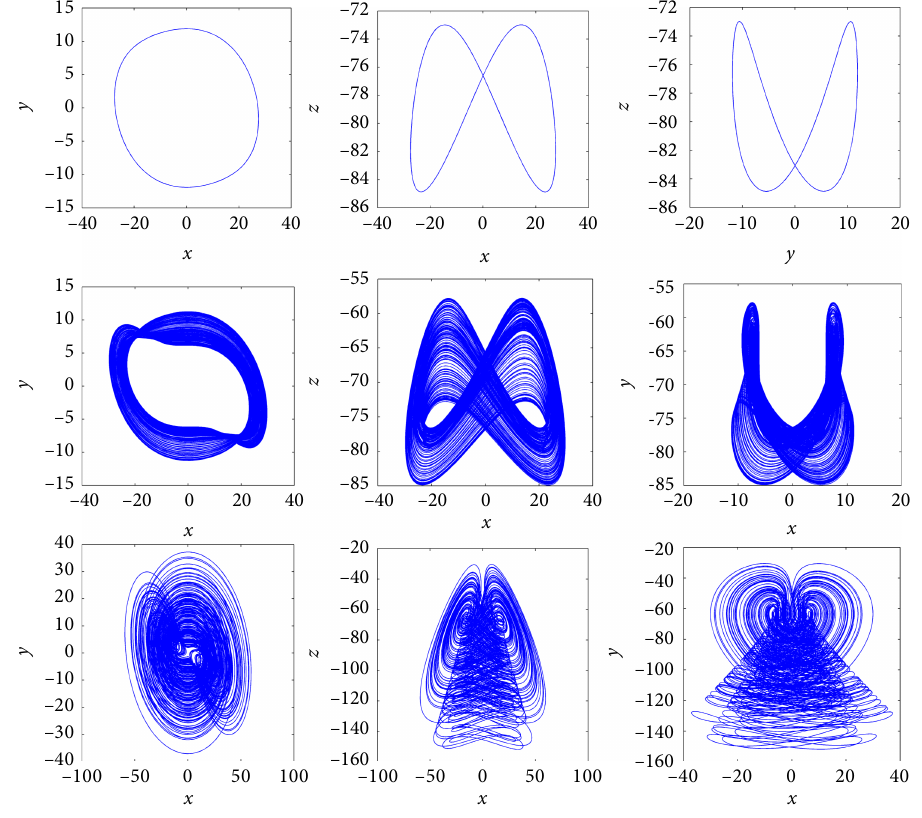
Figure 3: Typical phase portraits at 푎 = 5, 11.2 and 15 .